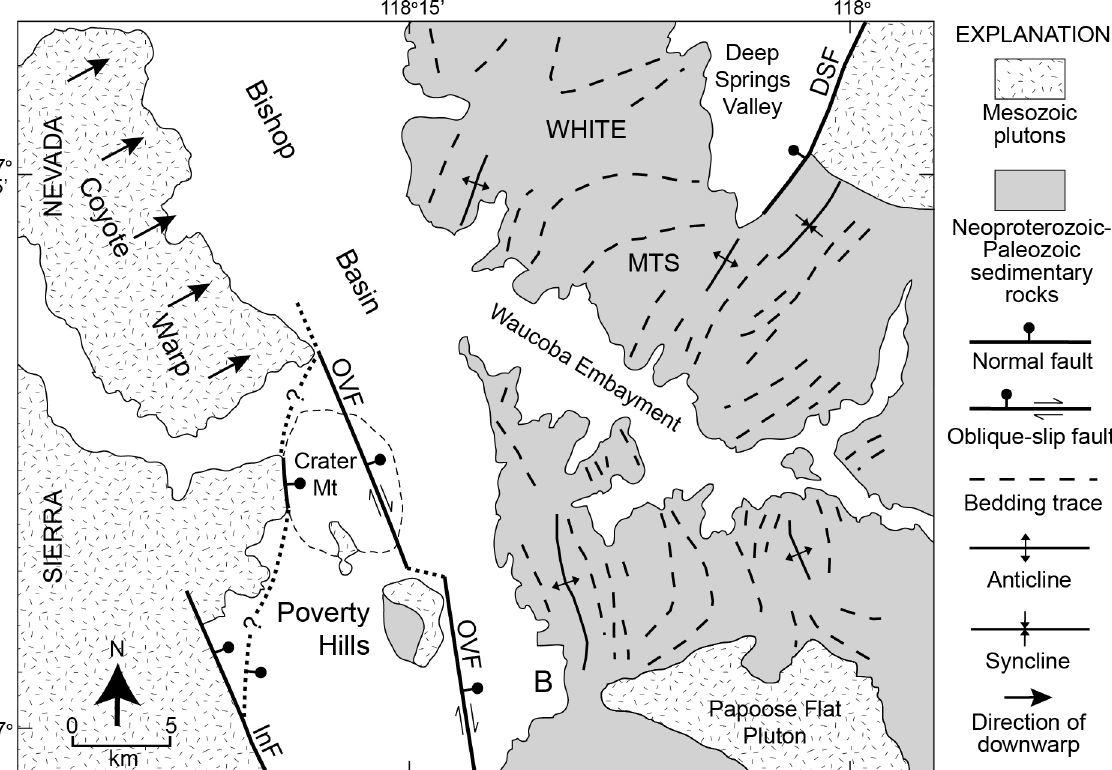
Figure 9. Geologic features in the White Mountains Structural Zone (WMSZ), including the Deep Springs Fault (DSF), the warping of bedding and folds across the Waucoba Embayment, the bight in the Inyo Mountains front (B), the southern boundary of the Bishop Basin, and the northward transition from the Independence Fault (InF) to the Coyote Warp [71,73]. OVF = Owens Valley